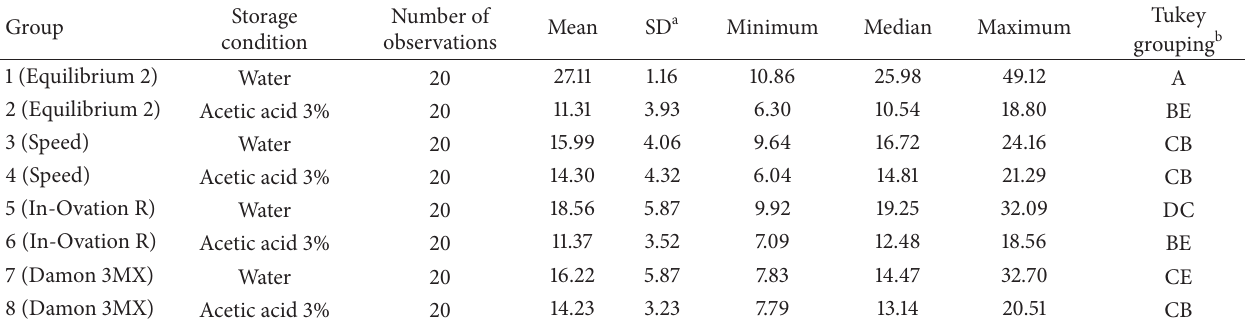
Table 1: Descriptive statistics of the four groups tested